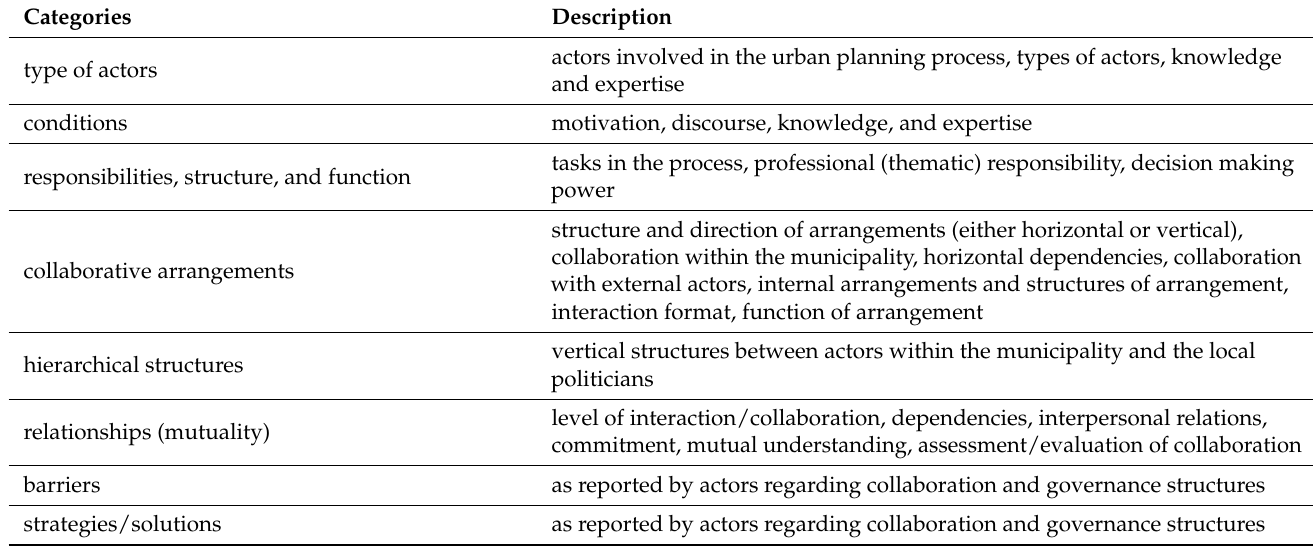
Table 3. Categories after step two.